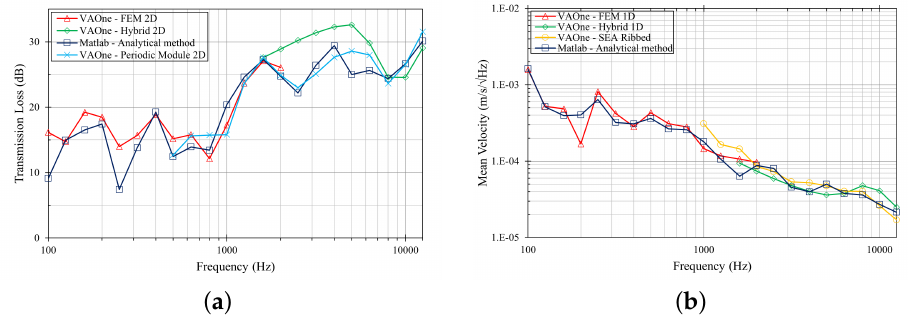
Figure 15. Vibro-acoustic responses of a panel with Z stiffeners (2D stringers): ( a ) sound transmission loss and ( b ) space-average mean vibration velocity.